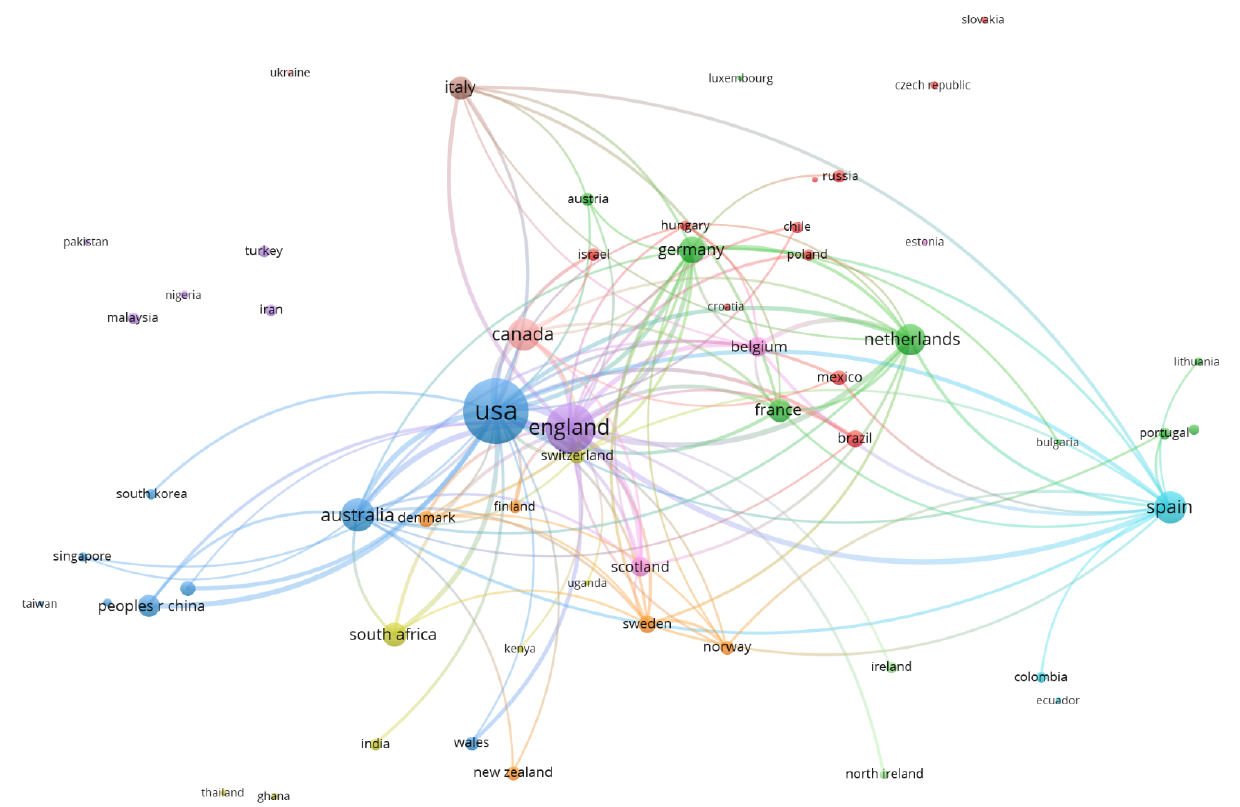
Figure 3. Co ‐ country network for “social cohesion.” The size of each node (circle) indicates the number of documents associated with a country [38]. Lines represent co ‐ occurrence between two countries and appear when countries co ‐ occur at least five times.